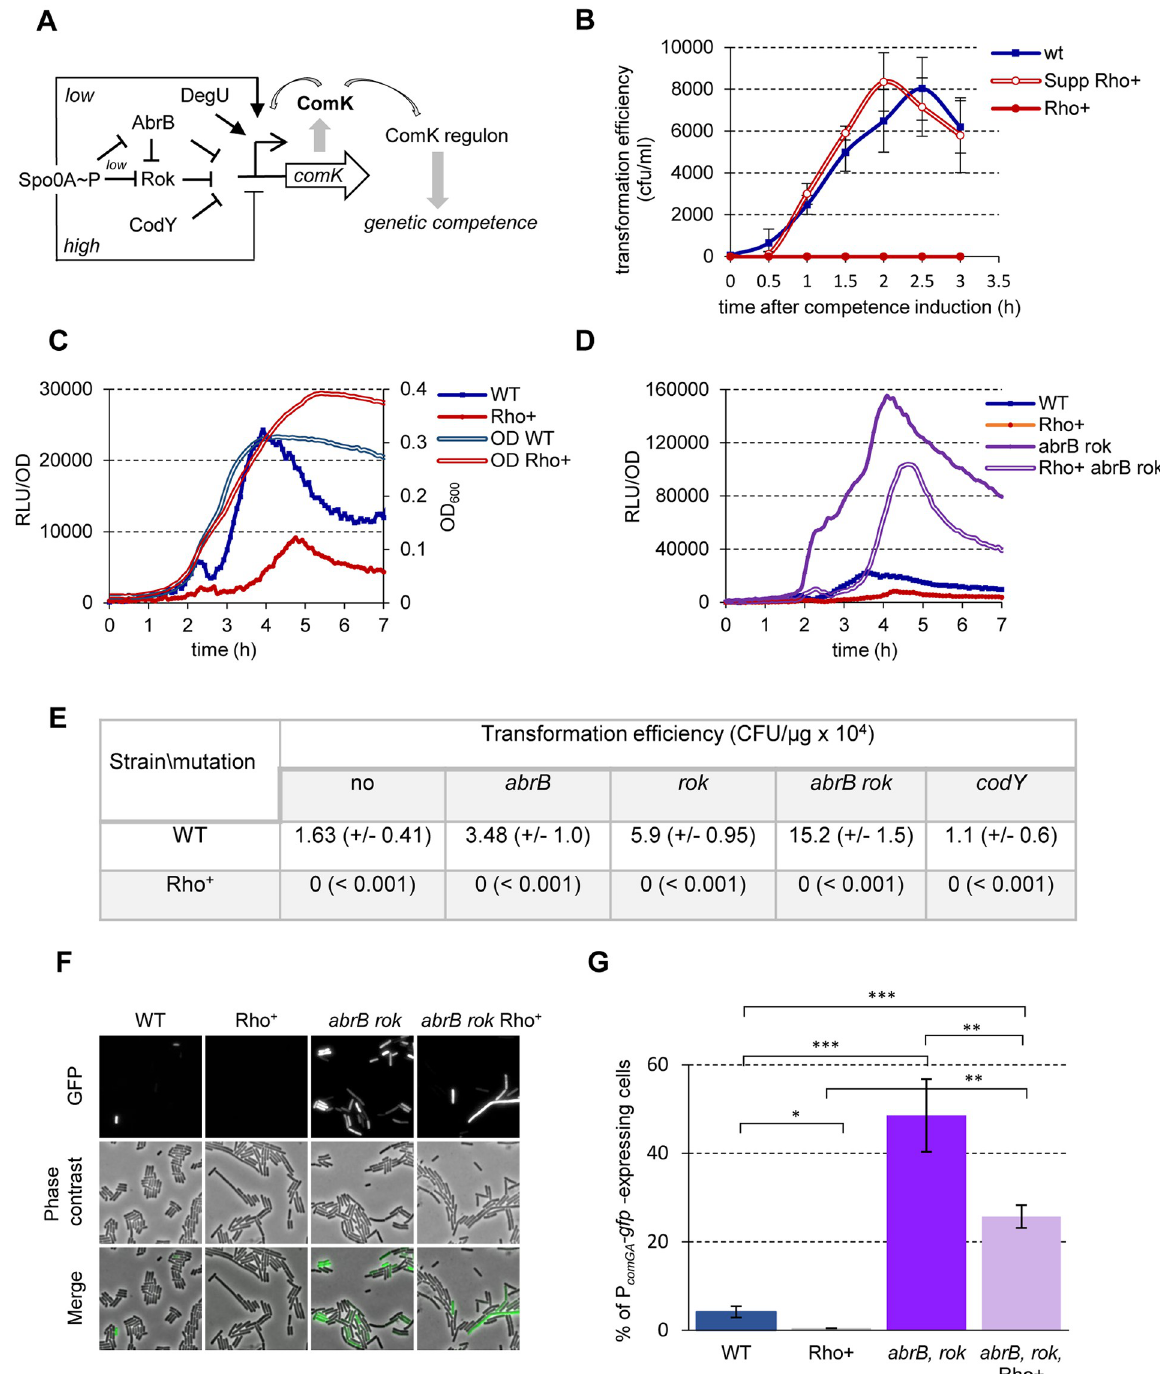
Fig 3. B . subtilis Rho + exhibits competence–negative phenotype. (A) Schematics of P comK regulation in B . subtilis cells. The promoter of the comK gene (P comK ) encoding the master regulator of competence is regulated by five transcription factors: Spo0A, Rok, AbrB, CodY, and DegU, and by ComK itself. The gradual increase in Spo0A * P first induces the P comK promoter activity directly (topmost arrow) and by antagonizing the transcriptional repressors AbrB and Rok, but represses it when concentration of Spo0A~P reaches a high threshold level (bottommost bar-headed line). Along with action on the P , AbrB represses the promoter of rok . ComK activates its own expression by direct binding to P assisted comK comK by the response regulator DegU. Eventually, an increase of ComK leads to the activation of the expression of DNA-binding, -uptake and -recombination genes that determines development of the competence state. Arrows and bar-headed lines represent positive and negative effects, respectively. (B) Kinetics of competence development in B . subtilis WT (blue line), Rho + (red line) and Rho + Q146Stop (red double-line) strains.